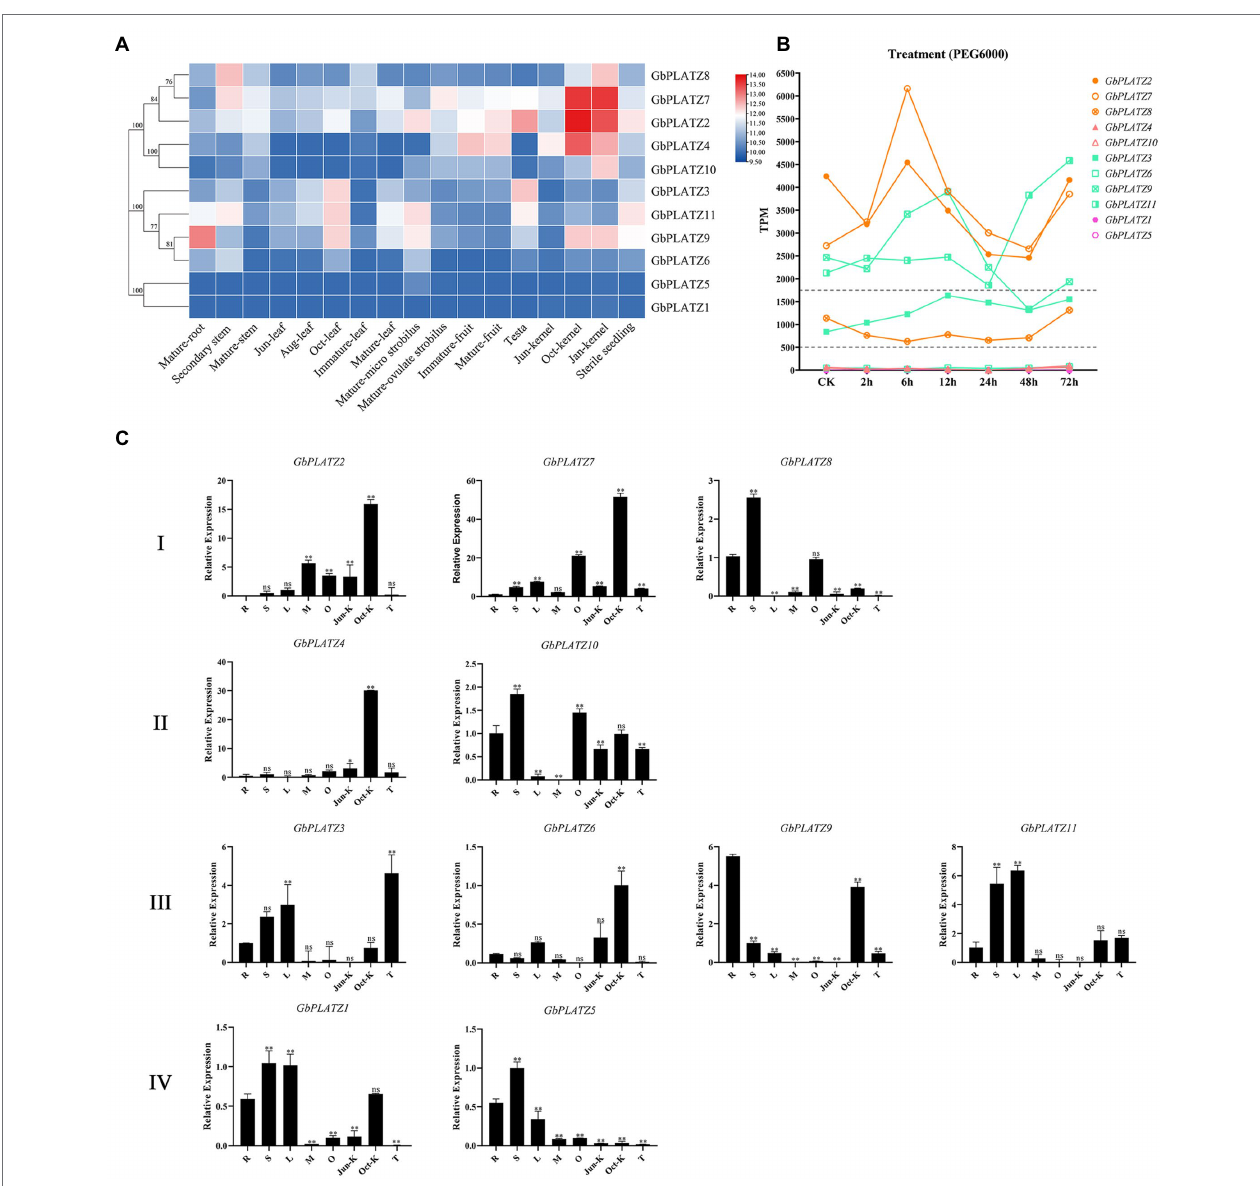
FIGURE 7 | Expression pattern analysis of GbPLATZ s. (A) Expression of GbPLATZ s in different tissues based on NCBI data. TPM values calculated by READ_ NUM were homogenized. The darker the red, the higher the expression level; the darker the blue, the lower the expression level. The evolution tree on the left of the heat map was drawn based on GbPLATZ gene sequence data and is consistent with Figure 2A . (B) The expression level of GbPLATZ s during PEG 6000 treatment based on NCBI data. The x-axis represents the time of PEG 6000 treatment, the y-axis represents the TPM value, and the dotted lines separate genes with distinct expression patterns. (C) Real-time quantitative data of each gene based on plant materials used in this study, the x-axis represents the different tissues. R, root; S, stem; L, leaf; M, micro-strobilus; O, ovulate-strobilus; Jun-K, kernel in June; Oct-K, kernel in October; and T, testa. F-test: ** < 0.01, * <